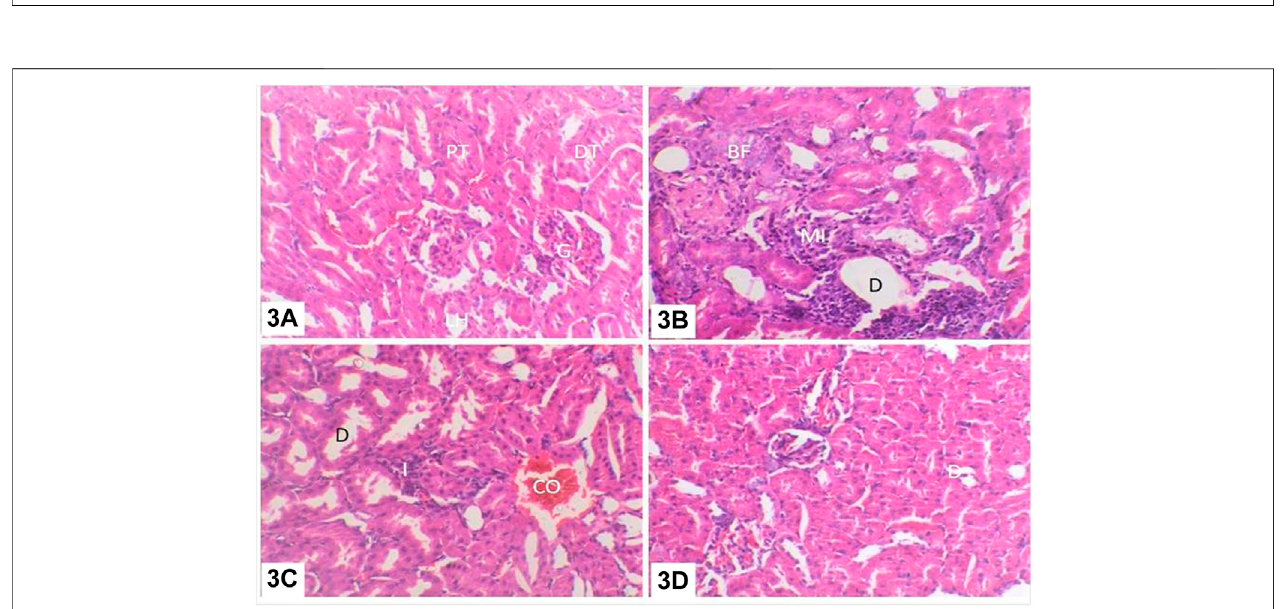
FIGURE 8 | (A) Kidneys of control rats: glomerulus (G), proximal convoluted tubules (PT), and distal convoluted tubules (DT); (B) kidneys of rats treated with water contaminated with dimethoate after remediation with ZnO(s)/H 2 O 2 /UV: intertubular mononuclear cell in fi ltration (MI), renal casts (RC), tubular dilatation (D), and tubular basophilia(BF); (C) kidneysofratstreatedwithwatercontaminatedwithmethomyl afterremediationwithZnO(s)/H2O2/UV:tubulardilatation(D)and venouscongestion (CO); (D) kidneys of rats treated with water containing ZnO (s)/H 2 O 2 without any insecticides: tubular dilatation (D).